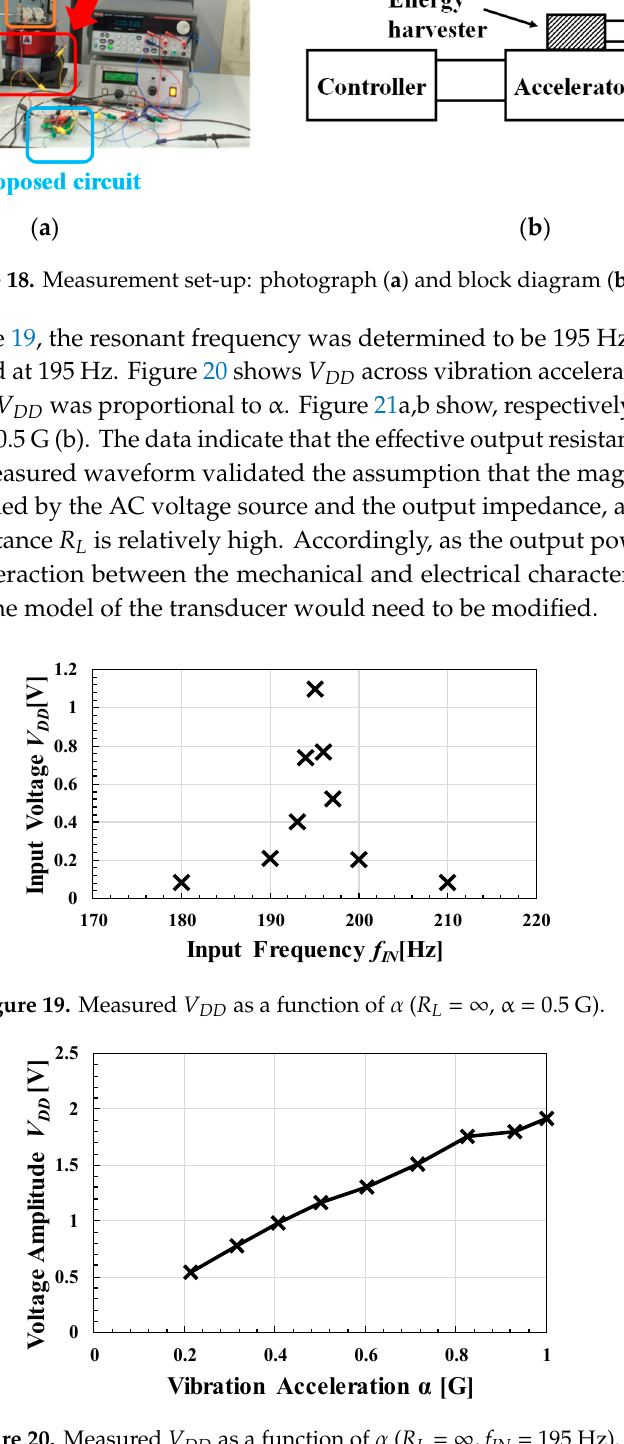
Figure 20. Measured V DD as a function of α ( R L = ∞ , f IN = 195 Hz).